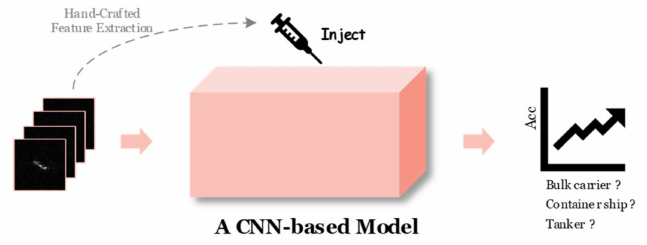
Figure 1. Diagrammatic sketch of the proposed injection technique.